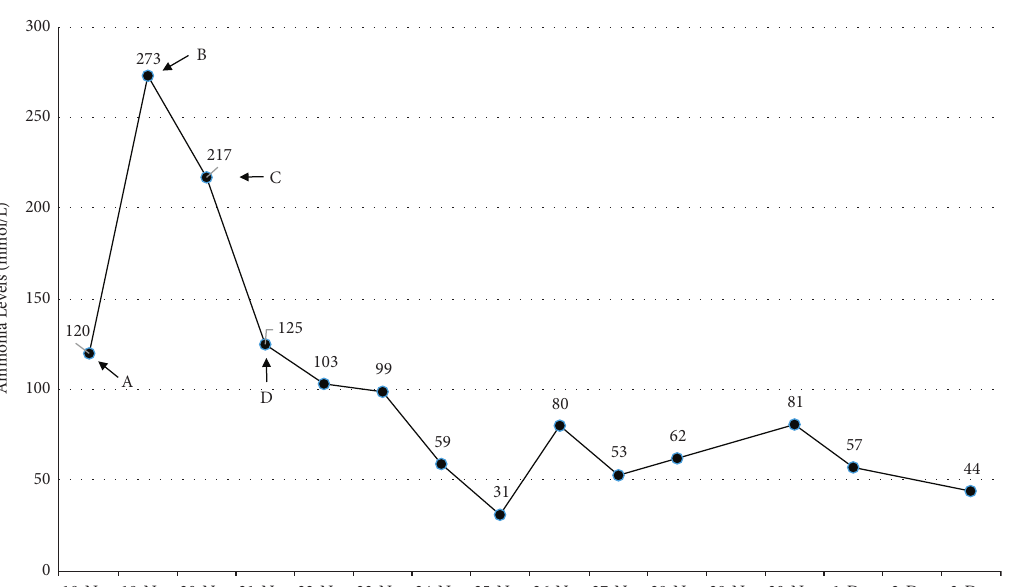
Figure 5: Trend of ammonia level over the course of this patient’s hospital admission. (A) Ammonia level on admission. (B) Initiation of lactulose enemas and CRRT. (C) L-Arginine and sodium benzoate/sodium phenylacetate started. (D) CRRT stopped due to recurrent clotting within the machine.